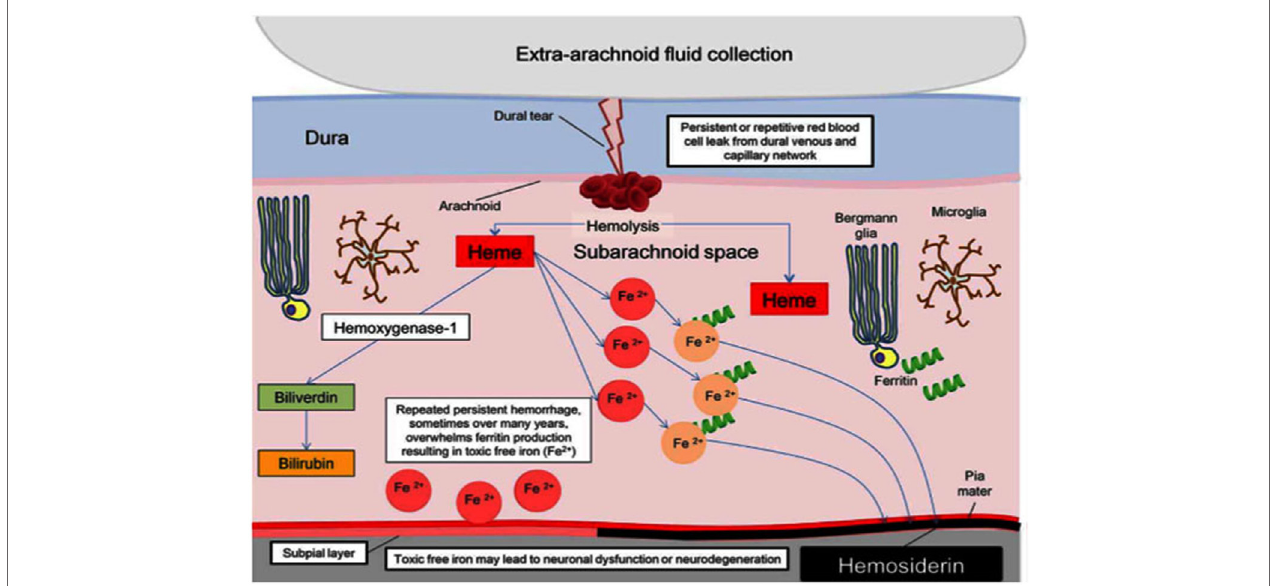
FiGURe 1 | Pathophysiology of hemosiderin damage in classical infratentorial superficial siderosis [from Wilson et al. (4)]. FiGURe 2 | Axial susceptibility weighed (SWI) magnetic resonance imaging (MRI) obtained in a 56-year-old man with post-traumatic iSS. The MRI, detected extensive hemosiderin deposition in the cerebellar folia (iSS) (a–e) . Panel (F) shows minimal cSS. He had paroxysmal positional vertigo involving the right posterior canal, bilateral, symmetric high-frequency-hearing loss, decreased vertical angular VOR gain in the vertical canals, except for normal right posterior gain. He has significant gait and limb ataxia. At age 4, he had a head injury during a MVA with prolonged coma.